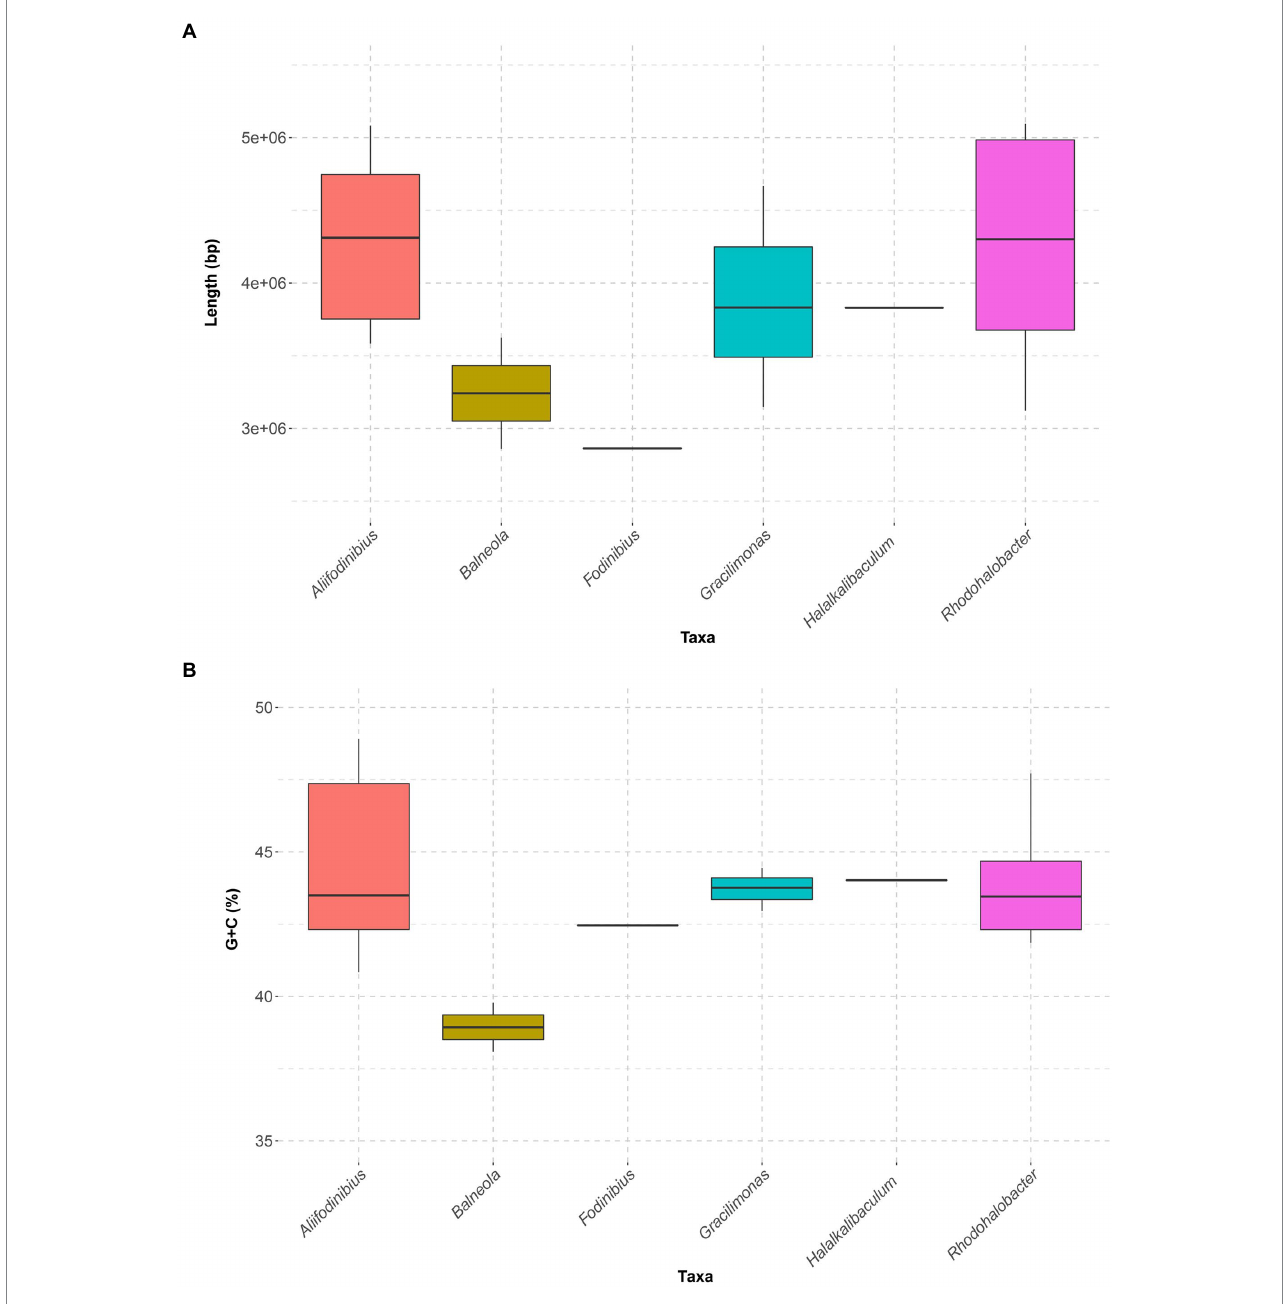
FIGURE 2 Boxplots summarizing genome size (A) and G + C content (B) of the genera of the family Balneolaceae , sorted alphabetically. The family Balneolaceae includes genera with very different genomes sizes, but their G + C percentages are mostly stable around 43 mol%, except for the type genus Balneola , below 40